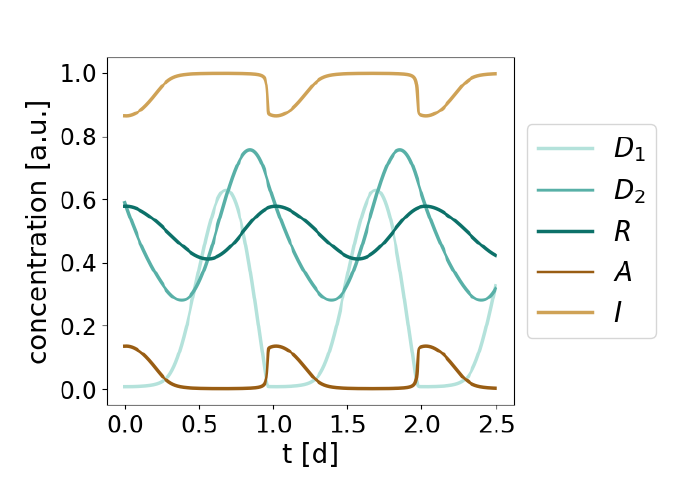
Figure 4. Dynamics of the redox model. Limit cycle oscillations obtained by numerical integration of the equations shown in Figure 2B for the following parameter values (arbitrary units, a.u.): p = 1, a = 1000, b = 2, d = 0.2, e = q = 0.1. Consistent with experimental data [11] and with the model